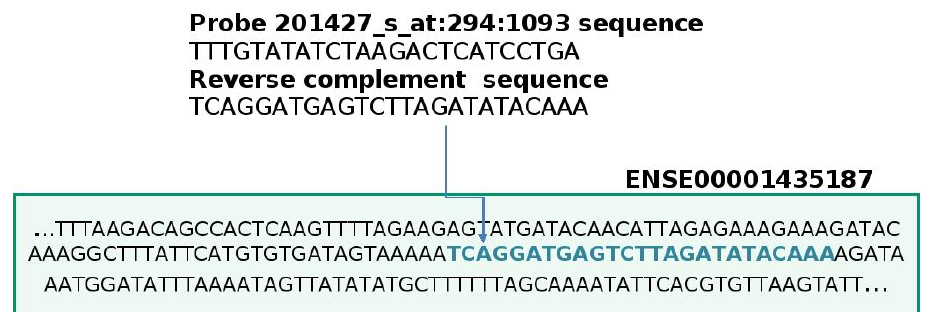
Figure 1. Probe 201427_s_at maps in an antisense direction to exon ENSE00001435187 (only a fragment is